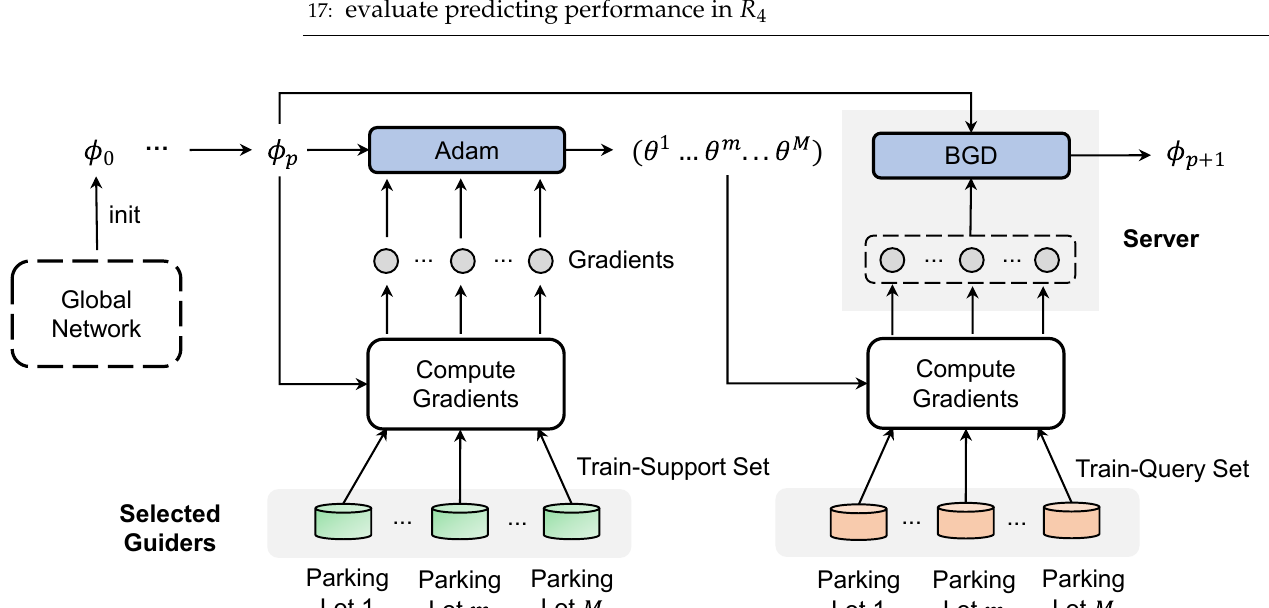
Figure 3. FedFOMAML pre-training framework in parking occupancy prediction